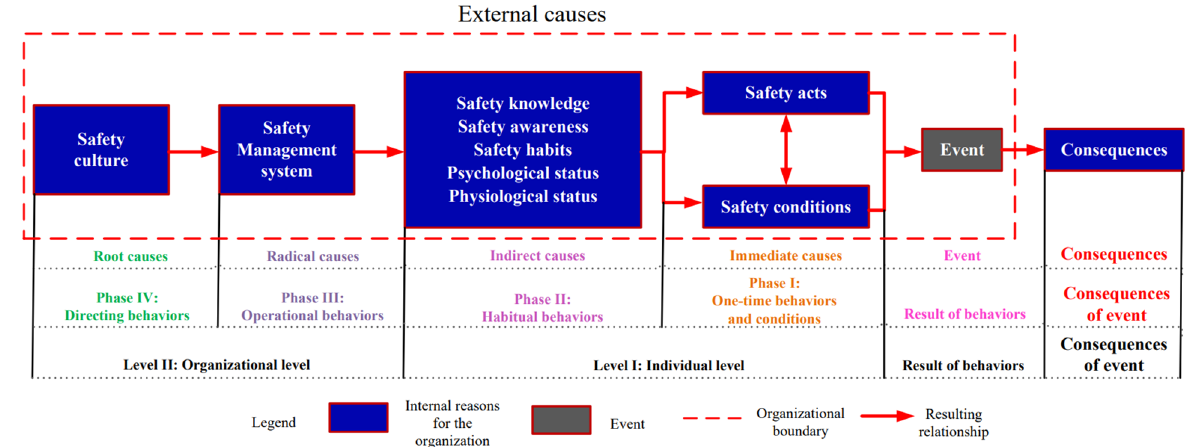
Figure 1. Latest version of Accident Causation 24 Model adapted from [17,18].